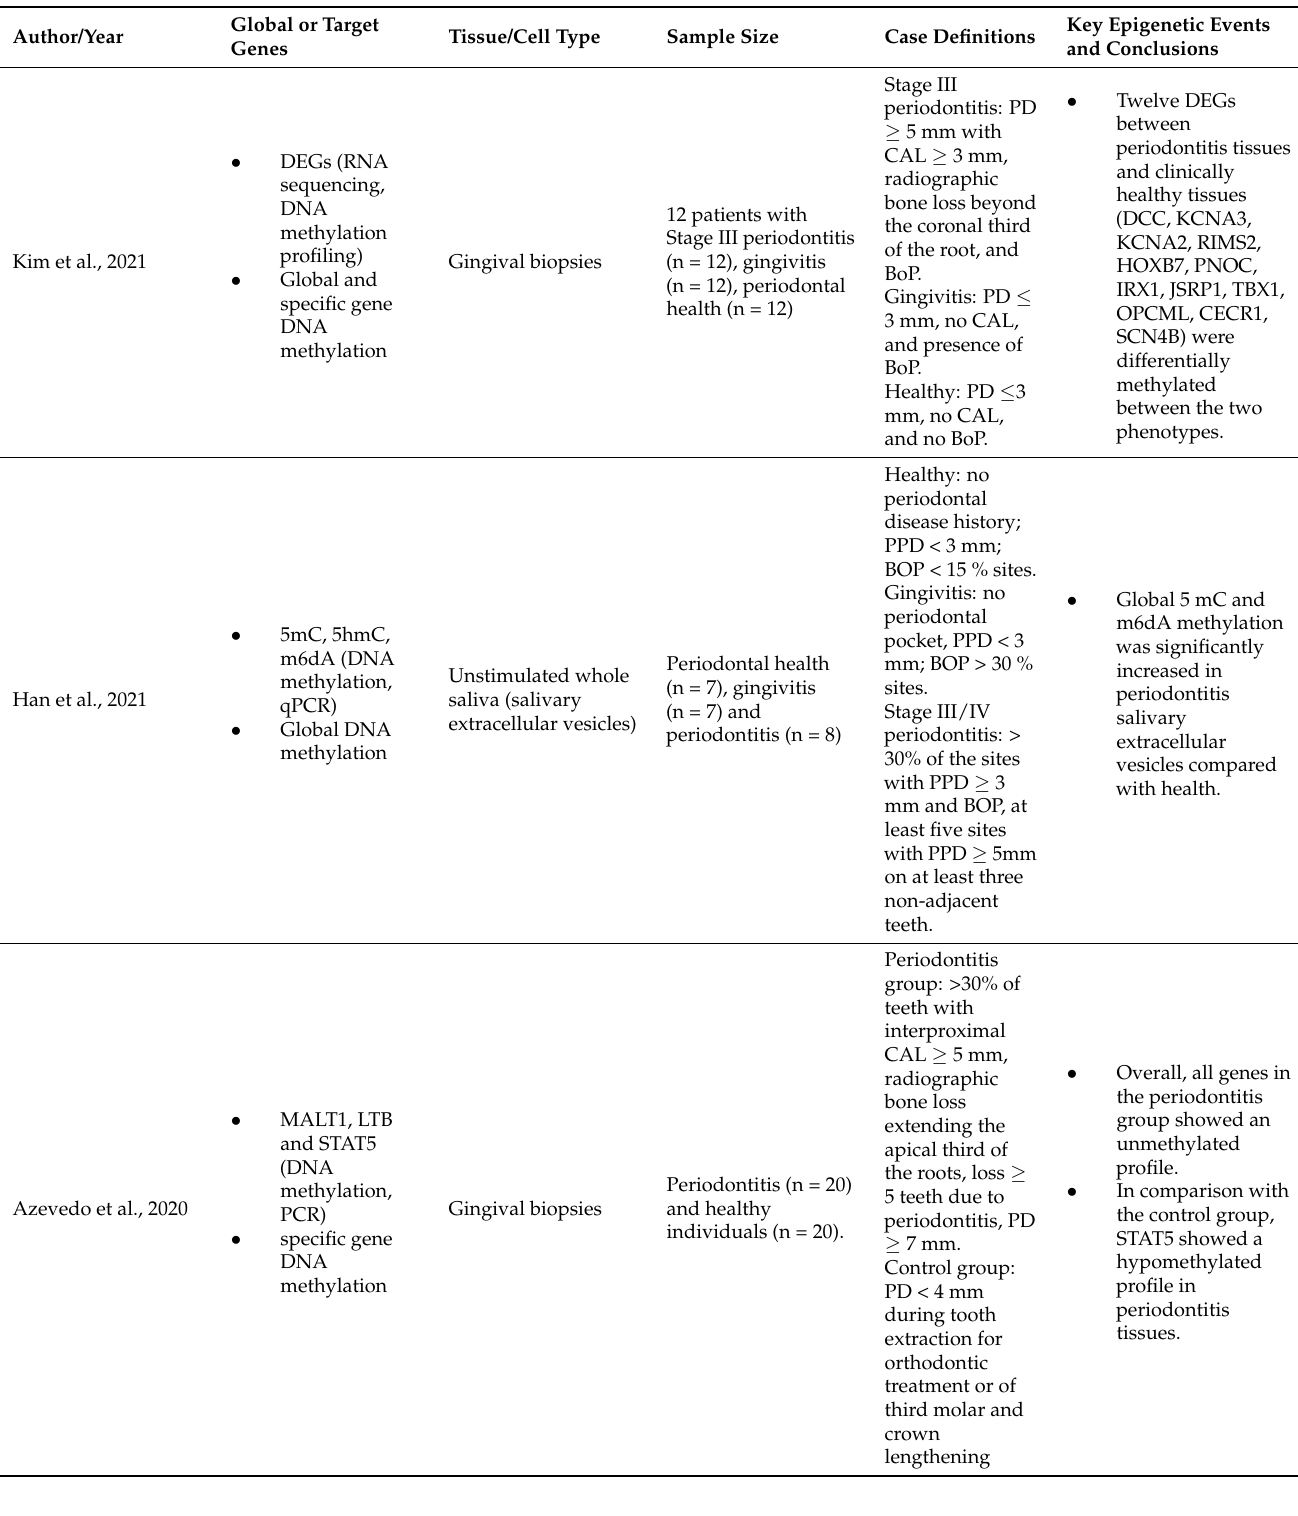
Table 1. Summary of selected publications included for analysis of the periodontitis-DNA methyla- tion